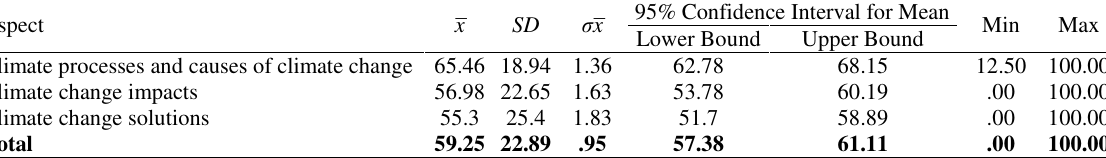
Table 2 Inferential analysis of the difference between the variances of scores from the three aspects of climate change science Sources of variation Between data sets (B) Within data sets (W) 581 Note: SS = Sum of squares; df = degrees of freedom; MS = mean squares.